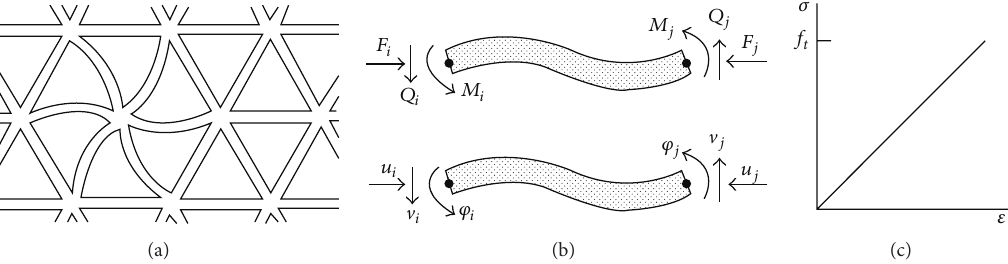
Figure 10: Triangular lattice of beam elements (a); external forces on a single beam element (b); stress-strain relation of a single beam element (c). After Schlangen